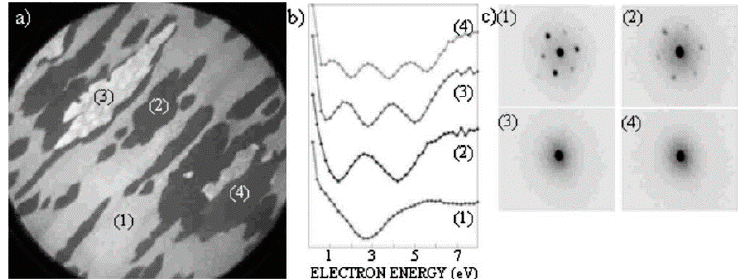
Figure 3. ( a ) LEEM image of graphene layers (FOV is 20 µm); ( b ) Electron reflectivity spectra extracted from the four representative areas 1–4 corresponding to graphene of 1–4 ML thick, respectively; ( c ) Micro-LEED collected from the four different areas